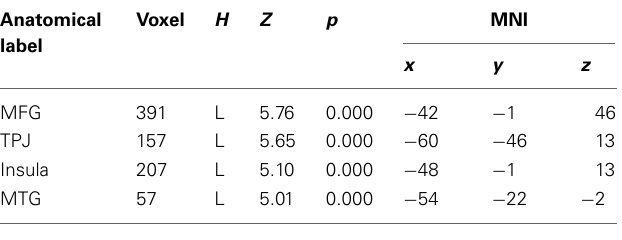
replicated, while also extended to uncover brain structures more generally involved in both mentalizing and interpreting other’s intentions in a more or less negative